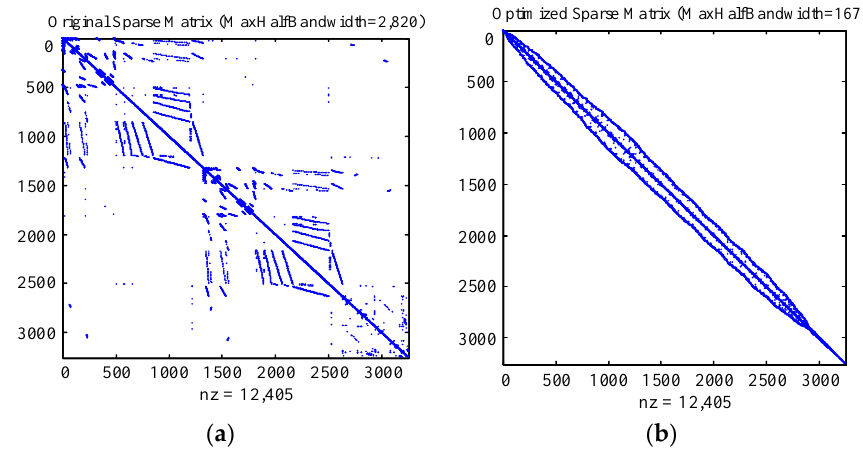
Figure 5. The comparison of the bandwidth of the bridge characteristic matrix before and after optimization: ( a ) Before optimization ; ( b ) After optimization . optimization: ( a ) Before optimization; ( b ) After optimization.